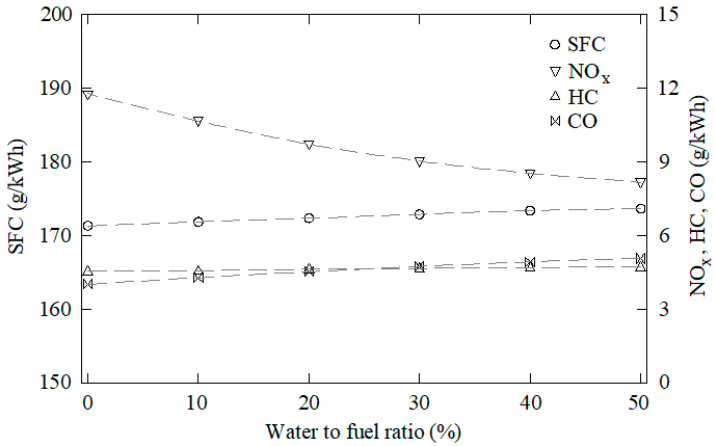
Figure 3. SFC, NO x , CO, and HC emissions against the water to fuel ratio. EGR rate = 0, overlap timing = 96°, intake valves closing = 568°, cooling water temperature = 76 °C.